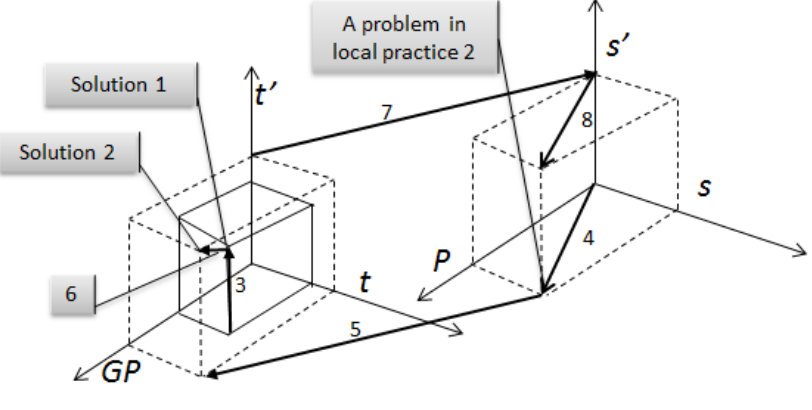
Figure 6. Project 1 – adjusting and testing solution for a new